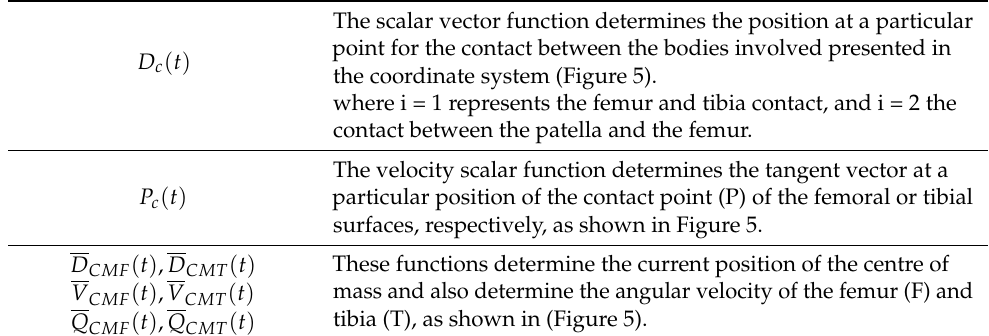
Table 1. Definition of the various functions to determine the points connecting the femoral or tibial surfaces. The scalar vector function determines the position at a particular point for the contact between the bodies involved presented in D c ( t ) the coordinate system (Figure 5). where i = 1 represents the femur and tibia contact, and i = 2 the contact between the patella and the femur. The velocity scalar function determines the tangent vector at a P c ( t ) particular position of the contact point (P) of the femoral or tibial surfaces, respectively, as shown in Figure 5. D CMF ( t ) , D CMT ( t ) These functions determine the current position of the centre of mass and also determine the angular velocity of the femur (F) and tibia (T), as shown in (Figure